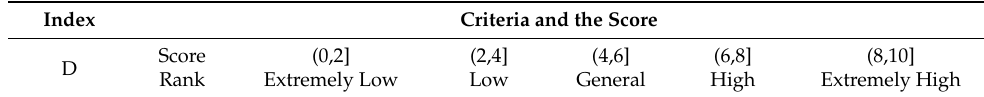
Table 7. Evaluation criteria of the technical